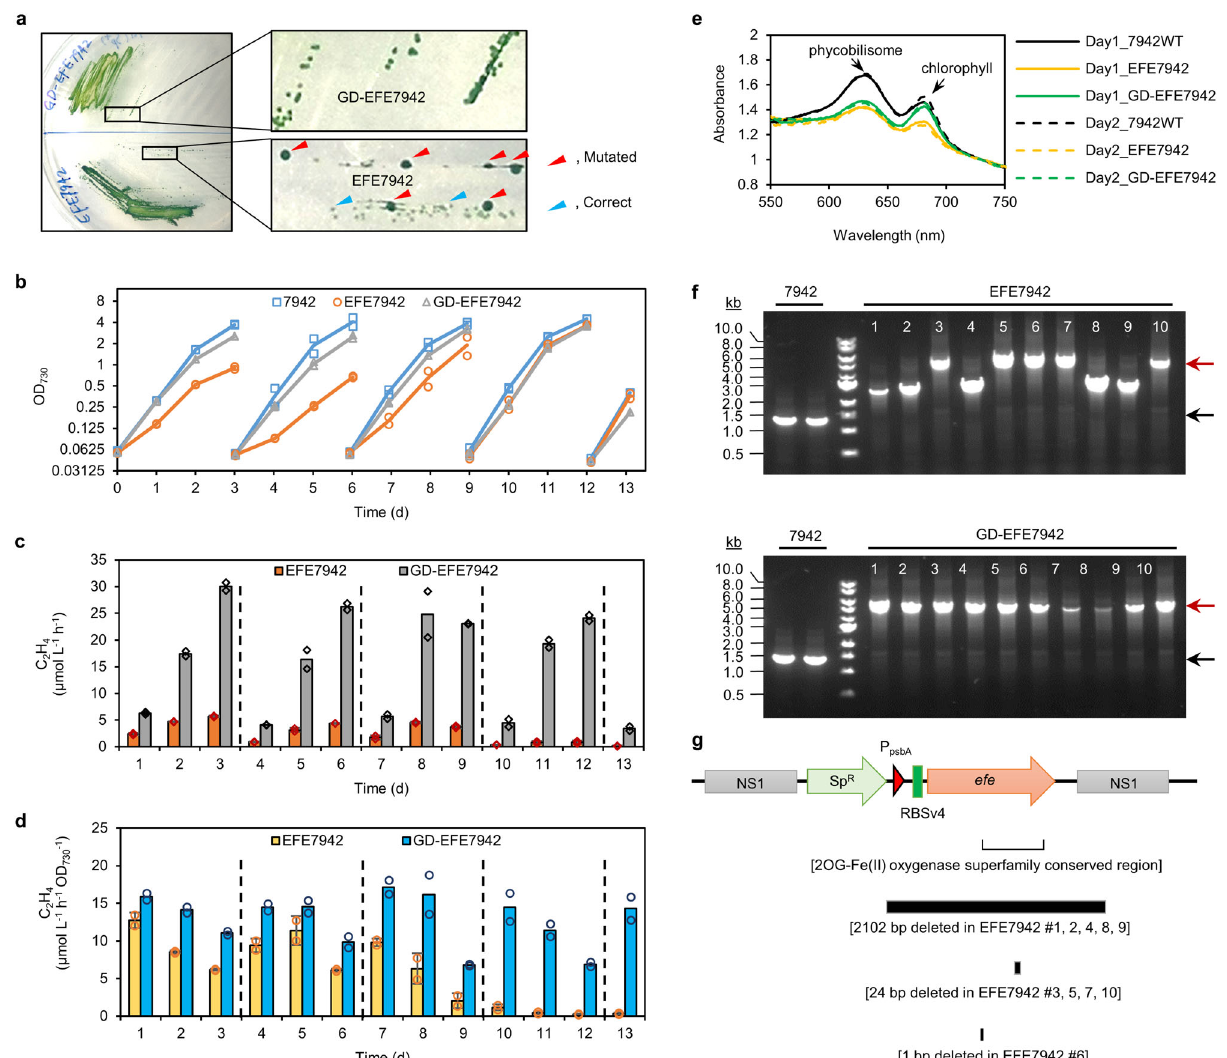
Fig. 6 Expression of sll1077 in Synechococcus 7942 supports sustained high-level ethylene production. a Colonies of strains EFE7942 and GD-EFE7942 formed on agar plates at 30 °C. DNA sequencing results revealed that for strain EFE7942, the smaller colonies indicated by cyan triangles harbored the correct EFE expression cassette, while the bigger colonies denoted by red triangles harbored mutated EFE expression cassettes; for strain GD-EFE7942, colony sizes were uniform and DNA sequencing identi fi ed no mutations around the EFE expression cassette. b Cell growth curves in liquid cultures at 30 °C. Cultures were re-inoculated into fresh BG11 medium (supplemented with 10 mM HEPES, pH 8.2, and 20 mM bicarbonate) media every 3 days. c Volumetric ethylene productivities of strains EFE7942 and GD-EFE7942. Data represent means of two independent biological replicates and are overlaid with individual data points. d Speci fi c ethylene productivities of strains EFE7942 and GD-EFE7942. Cultures were re-inoculated every three days. Data represent means and standard deviations from two biological replicates. Data represent means of two independent biological replicates and are overlaid with individual data points. e Absorbance spectra of cultures shown in ( b – d ) at day 1 and day 2. Absorbance was normalized to absorbance at 730 nm. f Two colonies of the wild-type strain 7942, ten colonies of strain EFE7942, and ten colonies of strain GD-EFE7942 were randomly picked from plates spread with diluted day-13 cultures shown in ( b – d ) and were subjected to colony PCR using primers fl anking the efe -insertion site on the genome. Red arrows indicate the expected PCR product size for strains EFE7942 and GD-EFE7942; black arrows indicate the expected PCR product size for the wild-type 7942 strain. Representative data from two independent experiments. g DNA sequencing of the PCR products obtained in ( f ) revealed mutations of the EFE expression cassettes on the genomes of all ten randomly picked EFE7942 colonies, whereas no mutations arose within the genomic region of the EFE expression cassette in any of the ten GD-EFE7942 colonies (Supplementary Data 2). Source data underlying panels ( b – d ) are provided as a Source Data fi